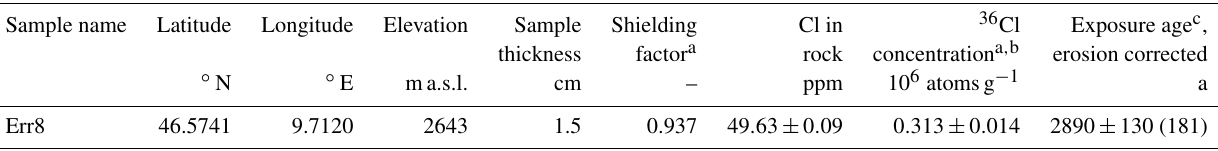
Table 2. The 36 Cl sample information of the Bleis Marscha rock glacier boulder (Main Dolomite) with location, sample information, blank- corrected AMS 36 Cl concentration, and calculated exposure